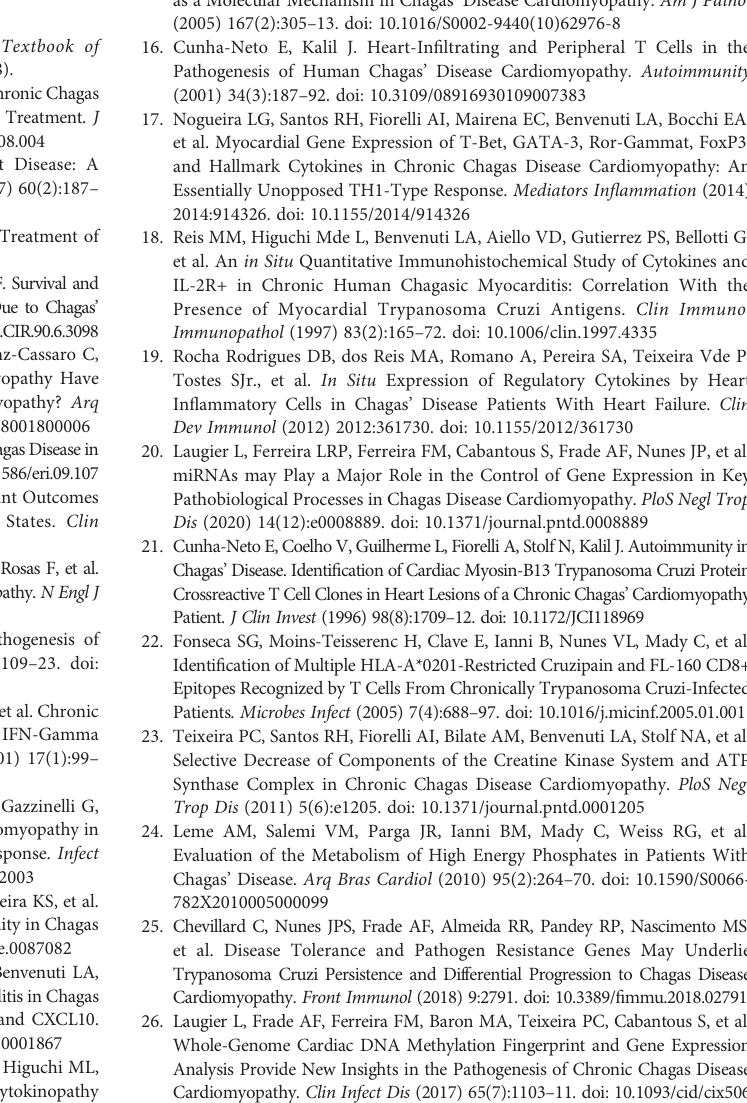
Supplementary Figure 5 | Protein Classi fi cation. (A) Cellular component classi fi cation and (B) biological process classi fi cation of proteins identi fi ed in the proteomic analysis. Supplementary Figure 6 | Protein and mRNA levels of DECR1 (2,4-dienoyl- CoA reductase 1) in myocardial tissue of CCC, DCM, IC and controls. (A) Densitometry measurement of DECR1 protein levels using immunoblot (One-Way ANOVA p = 0.0011). (B) . DECR1 mRNA levels assessed using real time RT-qPCR (One-Way ANOVA p = 0.0154). The horizontal lines show statistically signi fi cant changes between groups by the Tukey-Kramer test: *p < 0.05; ***p < 0.001. Supplementary Figure 7 | Cartoons depicting energy metabolism related proteins differentially expressed in CCC, DCM and IC myocardium. (A) Glycolysis,